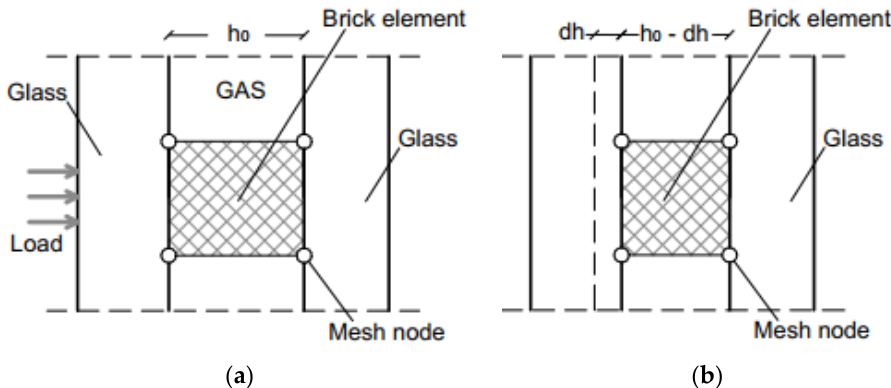
Figure 10. Reference FE numerical model: calculation of the input parameters for the equivalent cavity infill in ( a ) un-deformed and ( b ) deformed configurations.